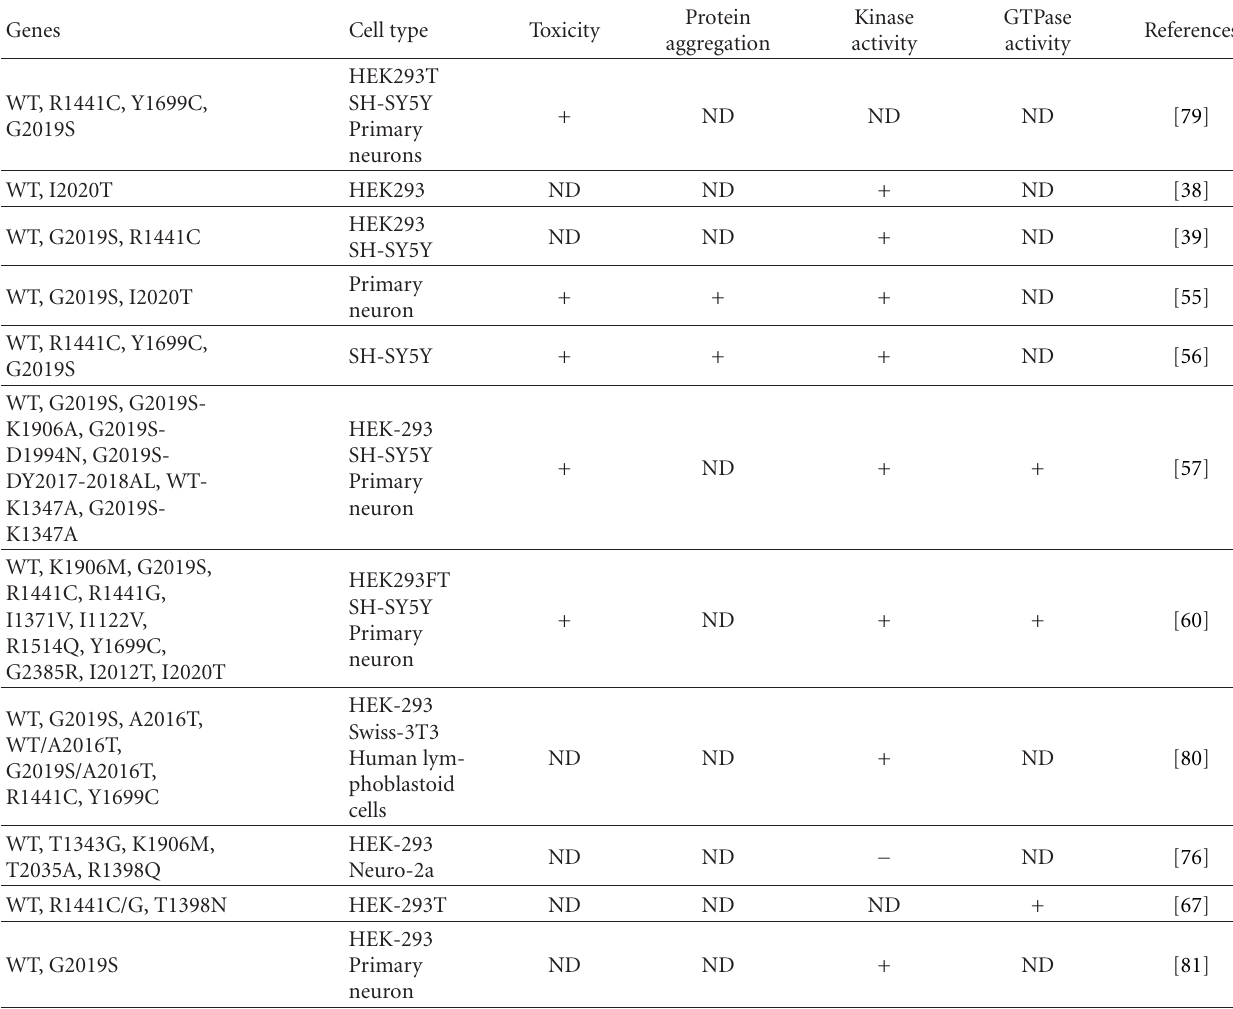
Table 1: LRRK2 in vitro cell